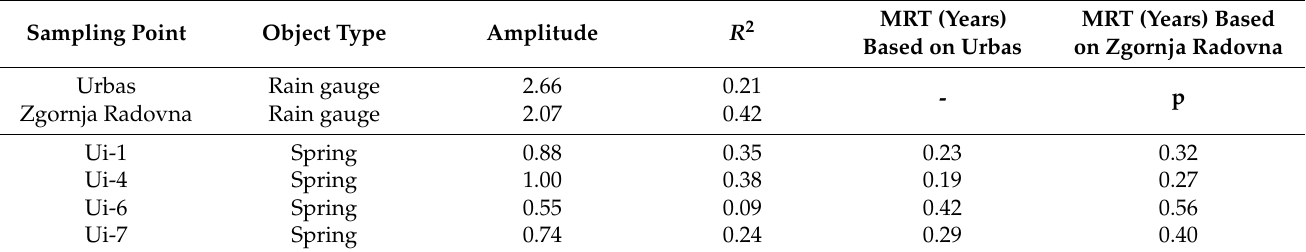
Table 5. Estimated MRT of water in springs in the Urbas